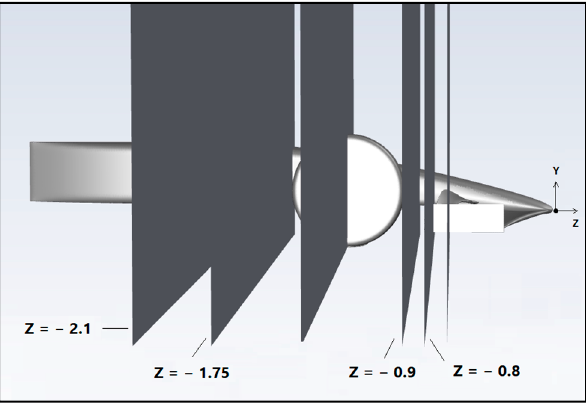
Figure 7. Measurement planes representation.